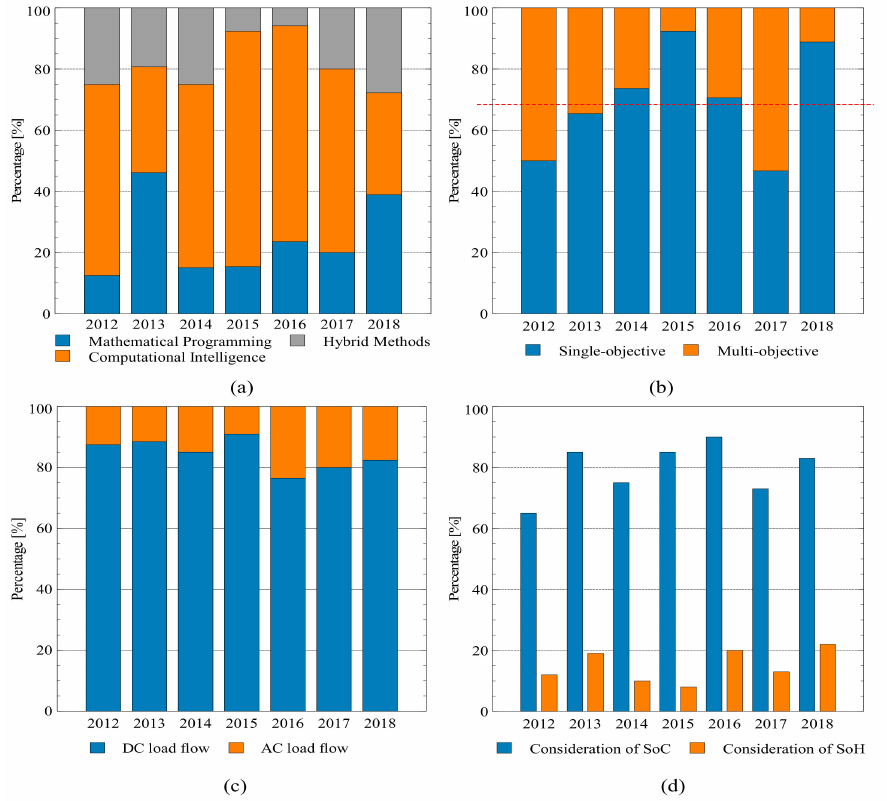
Figure 5. ( a ) Resolution techniques used in recent years, ( b ) Objective function types used in recent years, ( c ) Operating model types used in recent years and ( d ) Consideration of SoC and SoH in